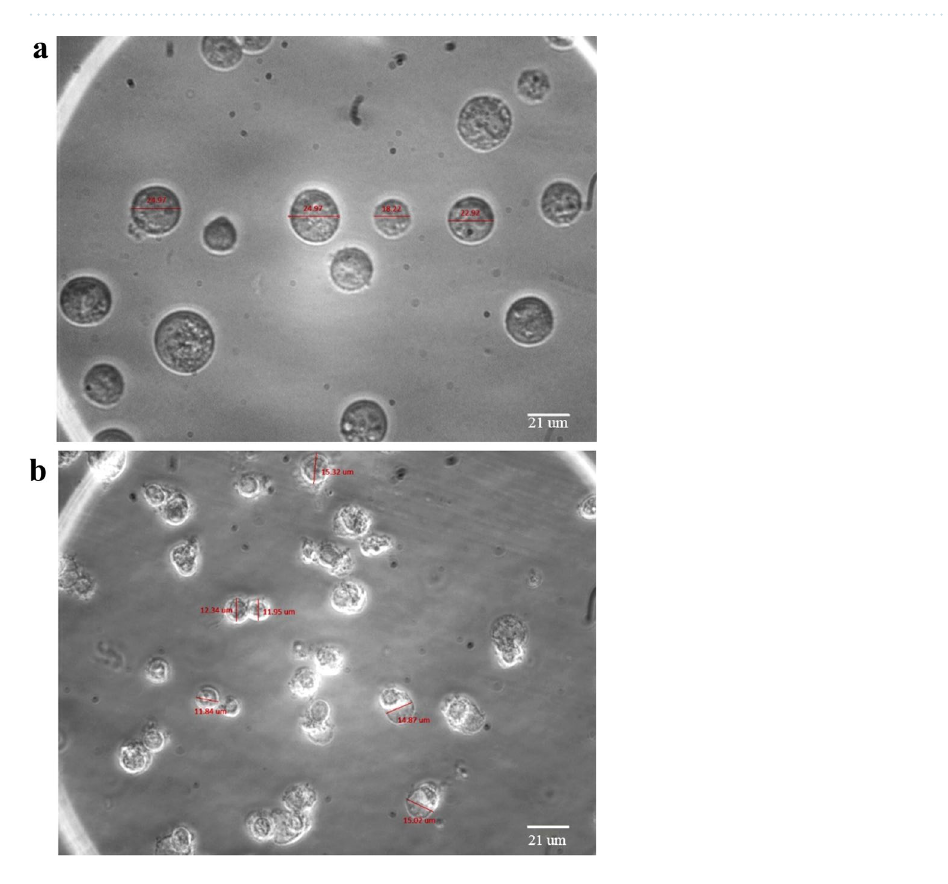
Figure 7. Size distribution of target and non-target cells. ( a ) MCF-7 cells with a mean diameter of 23 µm and ( b ) L929 cells with a mean diameter of 14